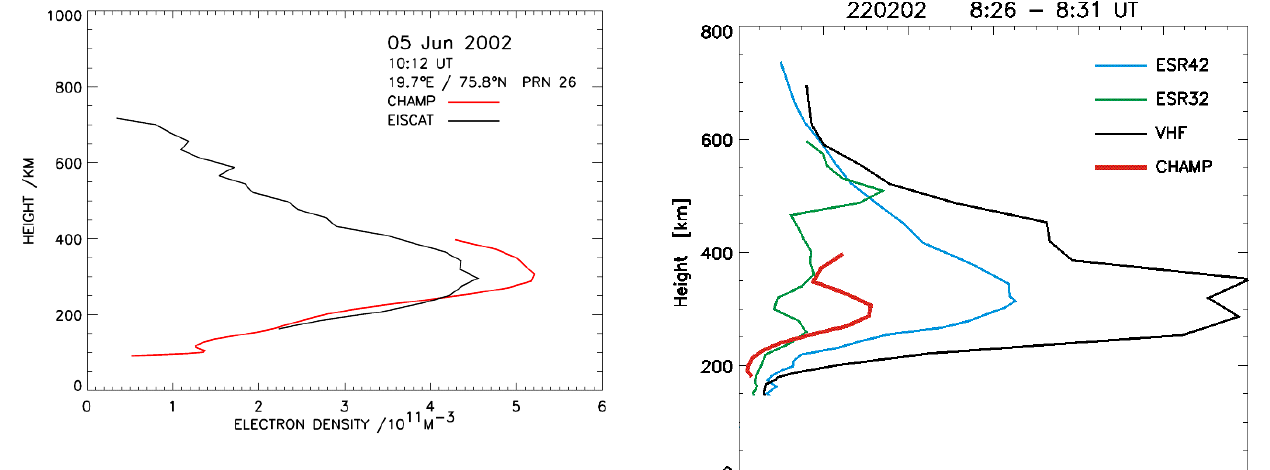
Fig. 5. Electron density values versus altitude measured along the vertical UHF (Tromsø) radar beam, together with the electron den- sity profile obtained from the occultation measurement.